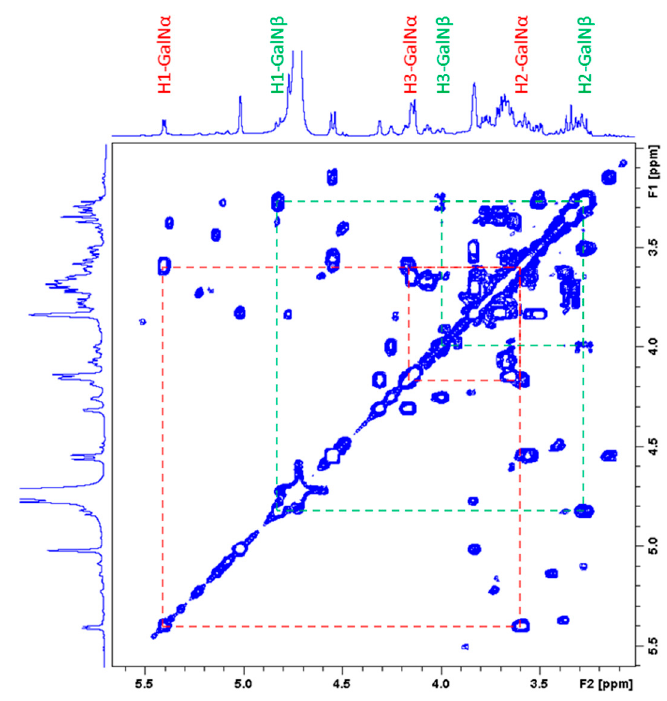
Figure A10. 1 H- 1 H COSY NMR spectrum of S. flexneri 6 OAg after TFA hydrolysis.